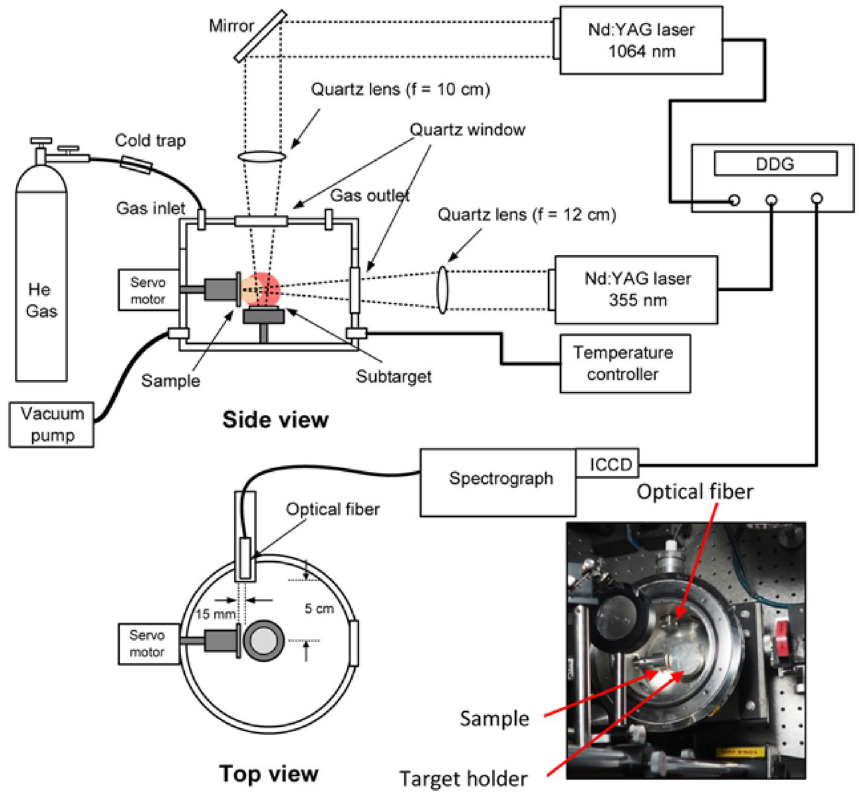
Figure 1. Schematic of experimental